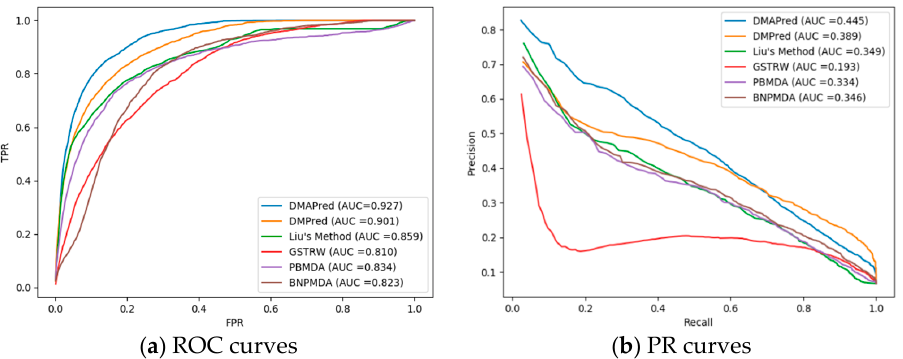
Figure 3. Two types of curves for evaluating the predicting performance of DMAPred and other five methods. ( a ) the Receiver Operating Characteristic (ROC) curves and area under the receiver operating characteristic curve (AUC) values of DMAPred and other five methods; and ( b ) precision–recall (PR) curves and area under the PR curve (AUPR) values of DMAPred and other five